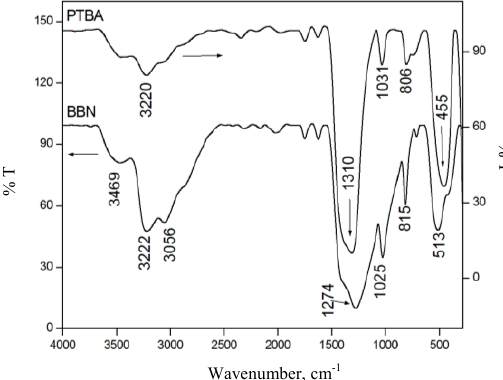
Figure 2. FTIR spectra of synthesized and modified BBN sorbents.